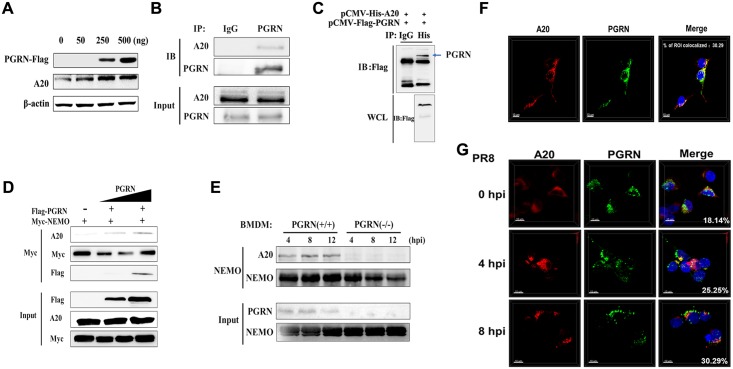
PGRN recruits A20 and facilitates A20-mediated deubiquitination of NEMO.(A) HEK293 cells were mock or transfected with vectors encoding FLAG-tagged PGRN at a concentration of 0, 50, 250, and 500 ng. Cell lysates were analyzed by immunoblotting with an anti-A20 antibody. (B) HEK293 cells were infected with PR8 virus at an MOI of 1. Cell lysates were immunoprecipitated with anti-PGRN antibody and probed with anti-A20 antibody. (C) Immunoblotting of HEK293 cells transfected with plasmids encoding FLAG-tagged PGRN and His-tagged A20 and assayed by Co-IP. (D) HEK293 cells were mock or transfected with vectors encoding FLAG-tagged PGRN and Myc-tagged NEMO and infected with PR8 virus at an MOI of 1 for 8 h. Cell lysates were immunoprecipitated with anti-NEMO antibody to analyze the recruitment of A20 to NEMO. (E) WT and KO BMDMs were infected with PR8 virus at an MOI of 2 for 4, 8 and 12 h. Cell lysates were immunoprecipitated with anti-NEMO antibody to analyze the recruitment of A20 to NEMO. (F) Confocal microscopy of HEK293 cells transfected with plasmids encoding FLAG-tagged PGRN and His-tagged A20. (G) Confocal microscopy of HEK293 cells transfected with plasmids encoding FLAG-tagged PGRN and infected with PR8 virus at an MOI of 1 for 0, 4 and 8 h. All data are representative of three independent experiments showing similar results.